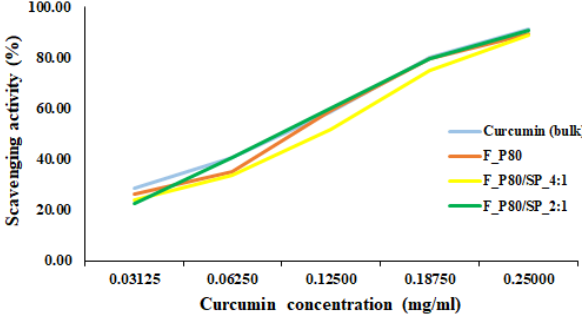
Figure 7: In vitro antioxidant activity assessment of the investigated curcumin nanocrystal dispersions: scavenging activity dependence on curcumin